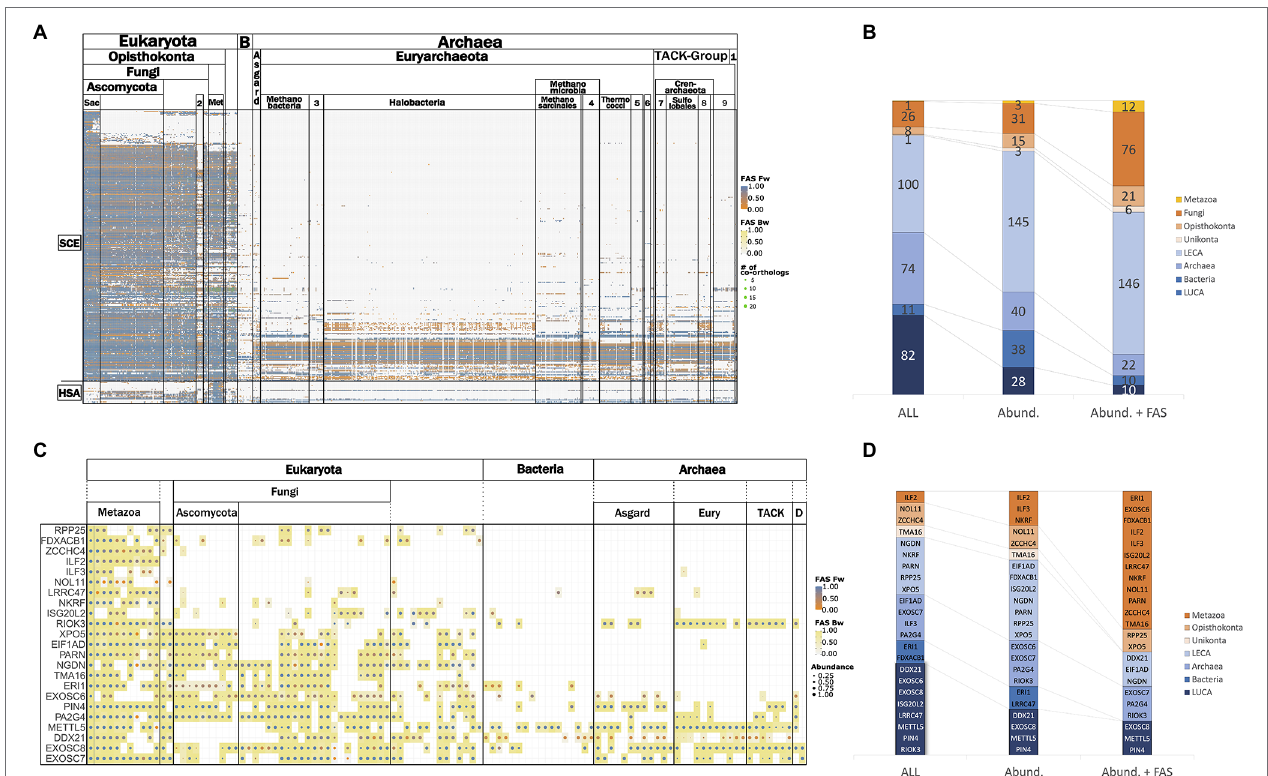
FIGURE 3 | Representation of RBF euk orthologs across the three domains of life. (A) Phylogenetic profile of the RBF euk set summarized on the class-level. Proteins are represented by the rows and columns represent the analyzed taxa. A dot in the matrix indicates that an ortholog for the respective RBF was found in this taxon. The dot color informs about the domain architecture similarity between the detected ortholog and the seed protein. (B) Phylostratigraphy of the RBF euk set based on the data shown in (A) filtered at varying levels of stringency (see main text). LECA – last eukaryotic common ancestor; Archaea – orthologs to an RBF are present in the archaea but not in the bacteria; Bacteria – orthologs to an RBF are present in bacteria but not in archaea; and last universal common ancestor (LUCA) – an ortholog was present both in archaea and bacteria. The two positive controls are placed in the Archaea stratum for the All and the Abundance filter, but are placed in LECA in the Abund. + FAS filter. (C) Phylogenetic profiles of the RBF human set summarized on the class level. The corresponding phylostratigraphies are shown in (D)